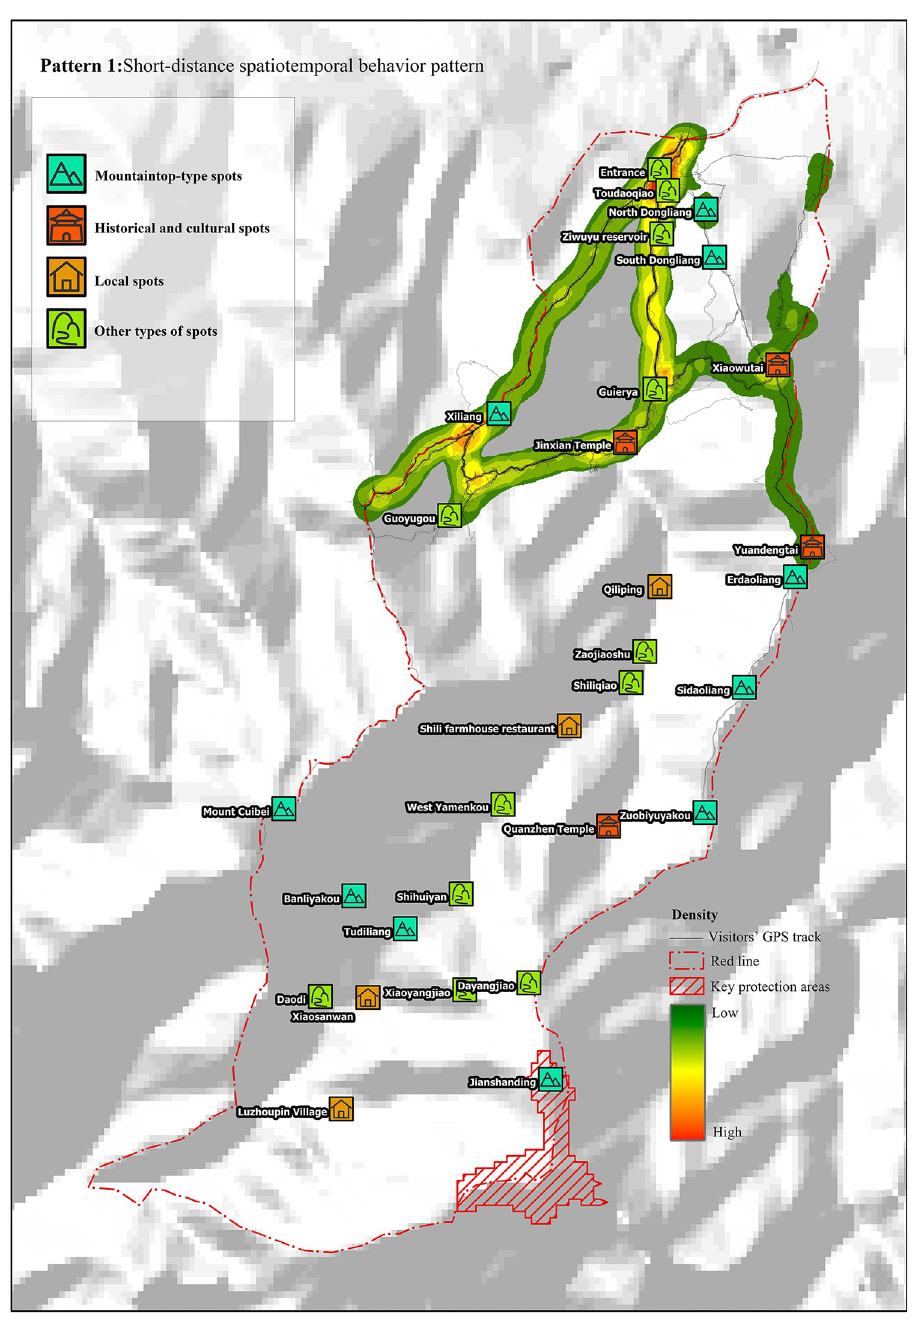
Fig 2. Short-distance spatiotemporal behavior pattern. Reprinted from [https://www.usgs.gov/centers/eros/data] under a CC BY license, with permission from [United States Geological Survey], original copyright [2000].